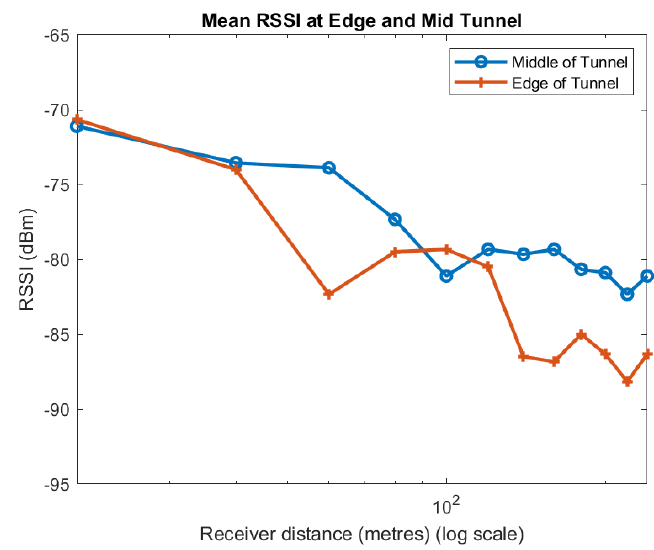
Figure 8. Effect of position in tunnel on RSSI: mean for all